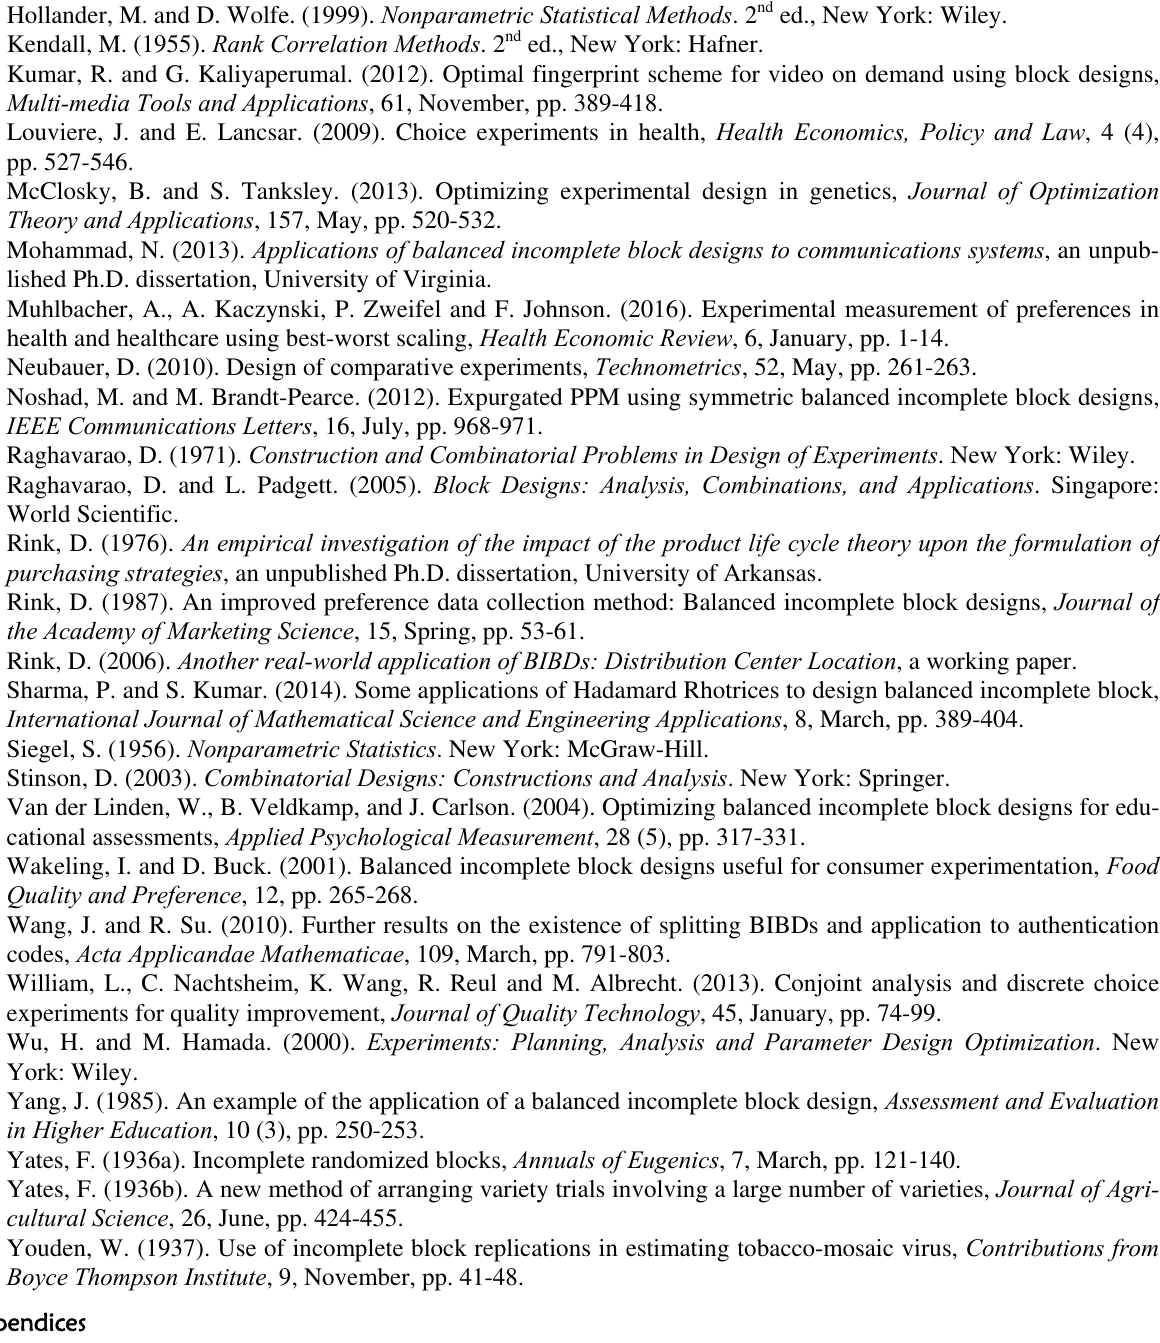
Table 1. Ranking of dimensions for selecting real estate